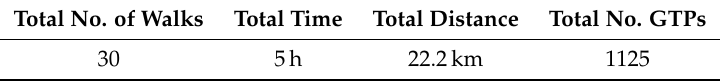
Table 2. Summary table of the experiments used in the